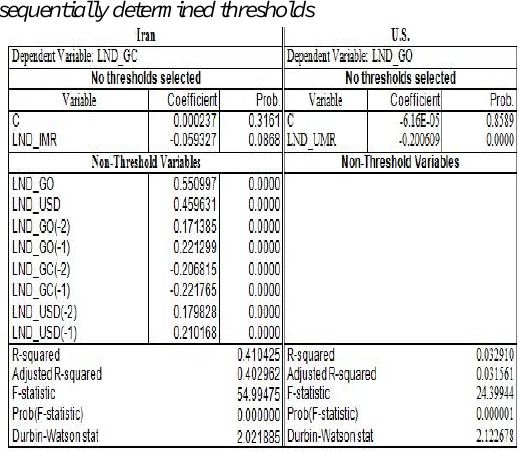
our model. Table 4, presents the results of implementing the model: Table 4: Investigating the Existence of Different Regimes in the Relationship between the Daily Returns of the U.S. and Iran's Stock Markets and